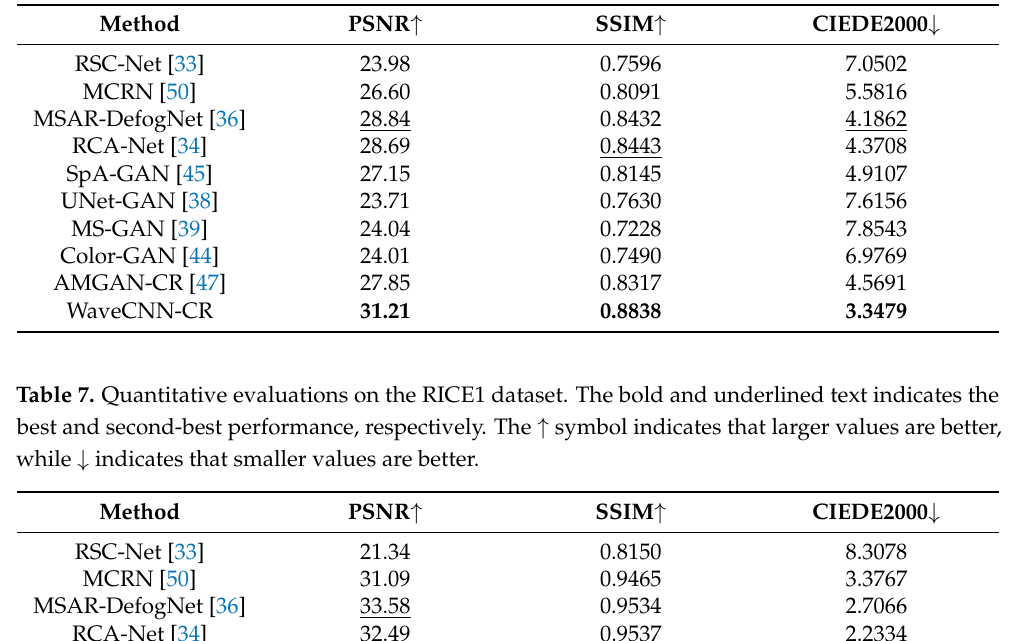
Table 6. Quantitative evaluations on the T-CLOUD dataset. The bold and underlined text indicates the best and second-best performance, respectively. The ↑ symbol indicates that larger values are better, while ↓ indicates that smaller values are better.